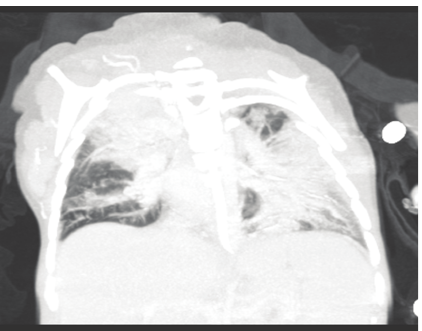
Figure 1: CT scan showing mediastinal enlargement and bilateral